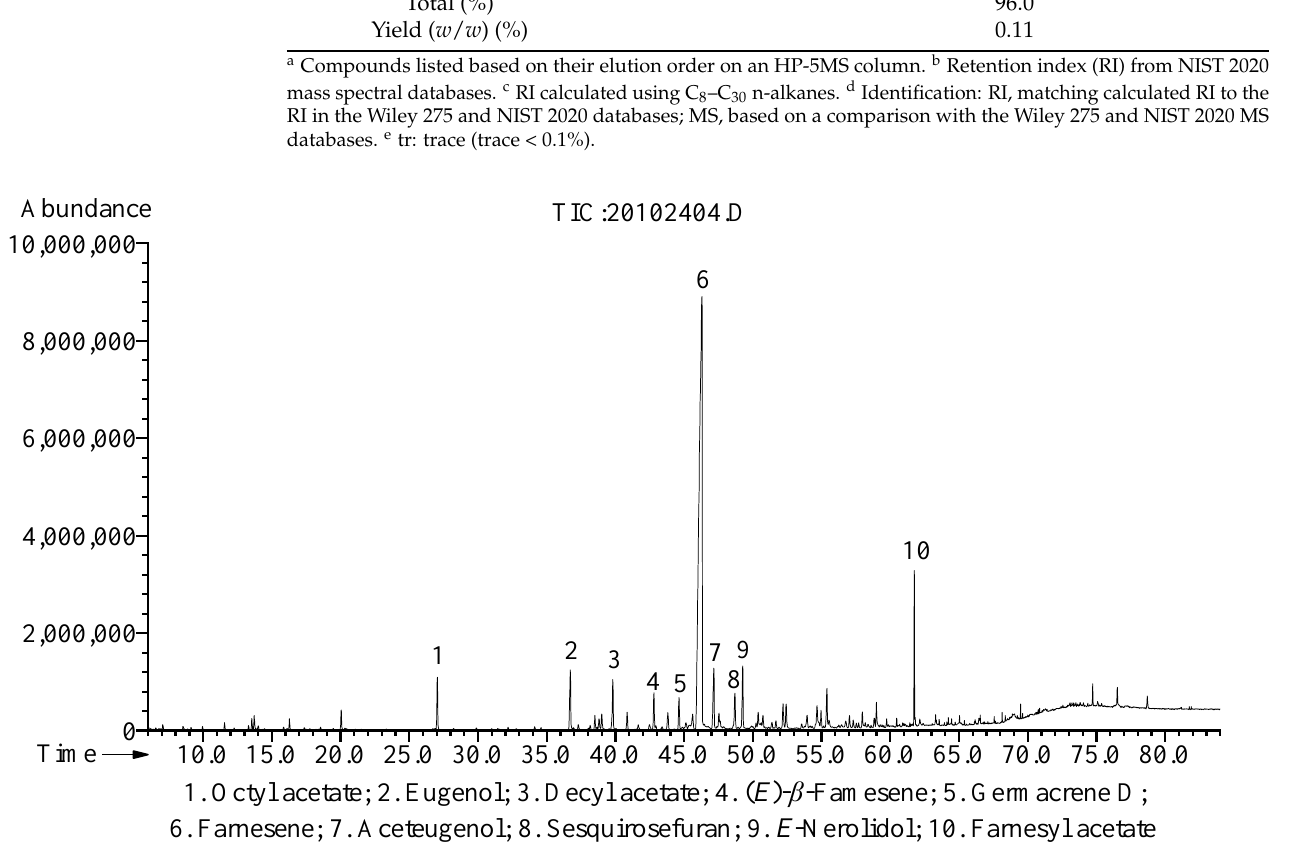
Figure 1. GC-MS chromatogram of the essential oil from A. galanga flowers. Table 1. Chemical compounds of the essential oil from A. galanga flowers.